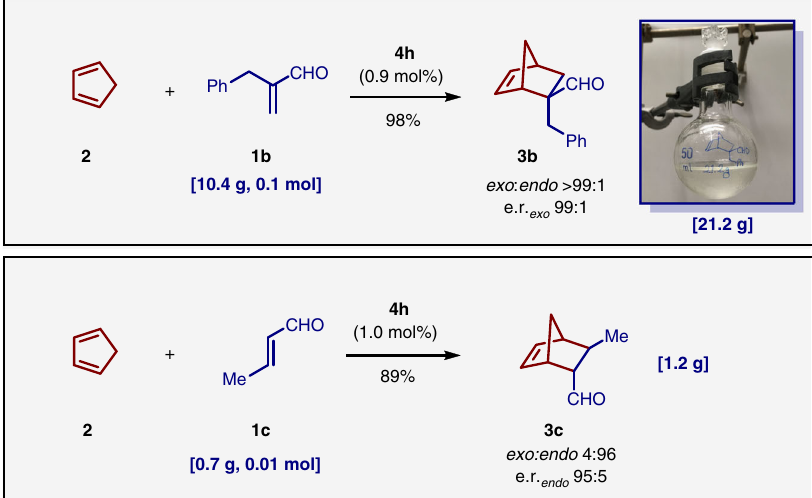
Fig. 3 Large scale experiments. Two gram scale experiments were conducted with each cyclopentadiene and aldehyde 1b and aldehyde 1c , respectively. 21.2 g of pure product 3b was